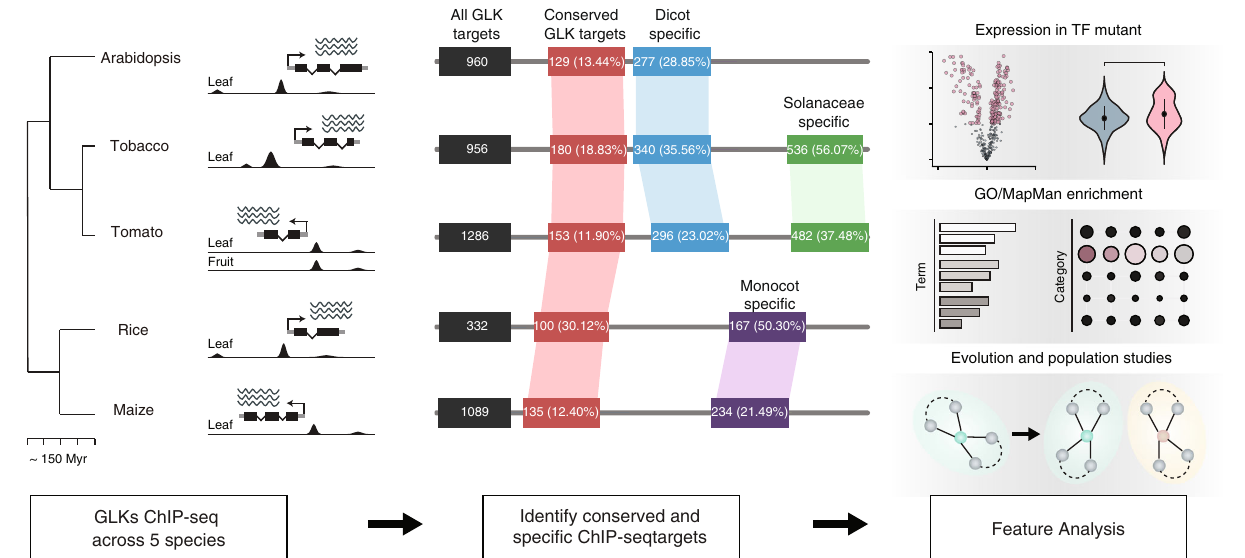
Fig.1|DivergenceofGLKTFbindingduringplantevolution. ChIP-seqisusedtodeterminethebindingofGLK1andGLK2inthe Arabidopsis ,tobacco,tomato,rice,and maize genomes. The conserved and speci fi c GLK ChIP-seq target genes are identi fi ed, and their features were investigated.